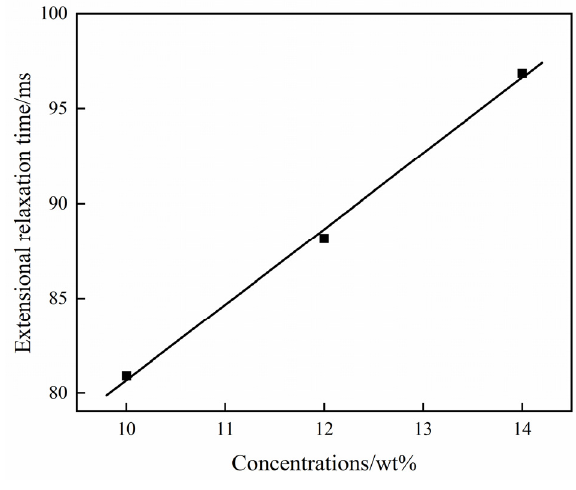
Figure 6. Extensional relaxation time versus polymer concentration.